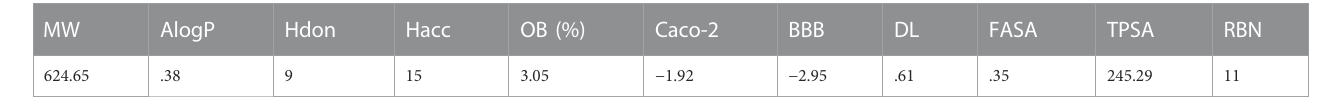
TABLE 1 Pharmacological and molecular properties data of